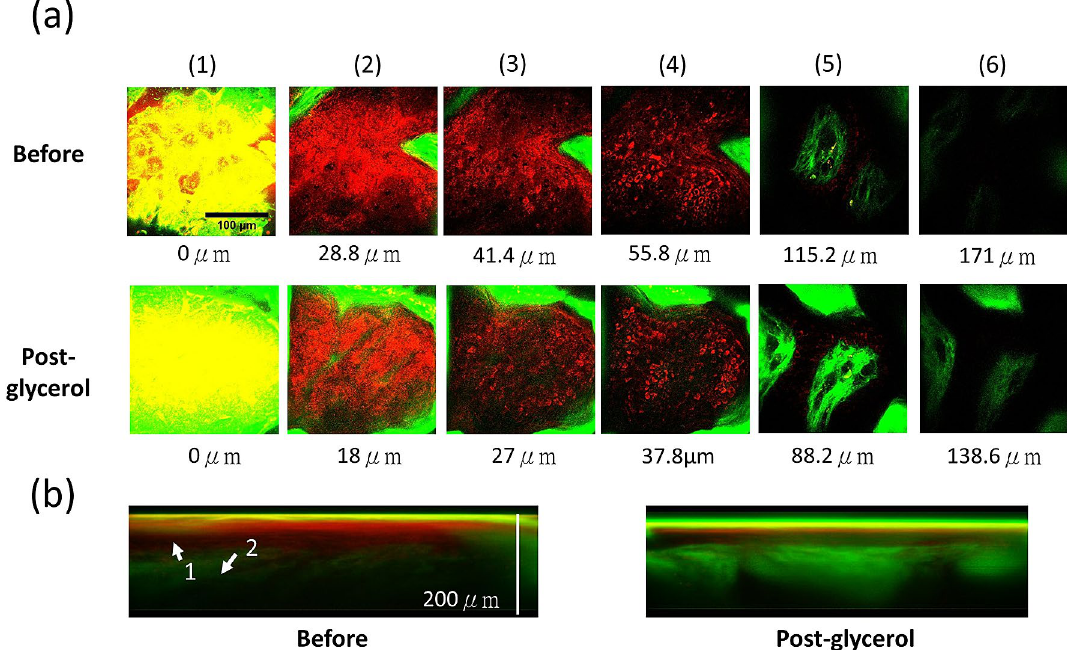
Figure 3. Ex vivo HGM images of Case E100-I90-2, with 100% glycerol immersion. ( a ) En face HGM images of (1) Top layer of the SC, (2) Bottom layer of the SC, (3) Middle layer of the viable epidermis, (4) Basal layer, (5) Middle layer of the papillary dermis, and (6) Top layer of the reticular dermis. Scale bar = 100 μm. ( b ) Transverse HGM images. In the layer of SC, the strong two-photon fluorescence leakage of the residue marking dye into the SHG channel is observable and is not included in our SHG analysis. The significant depth difference of the corresponding layer is attributed to the sample shrinkage post glycerol immersion. Arrow 1: Epidermis; Arrow 2: